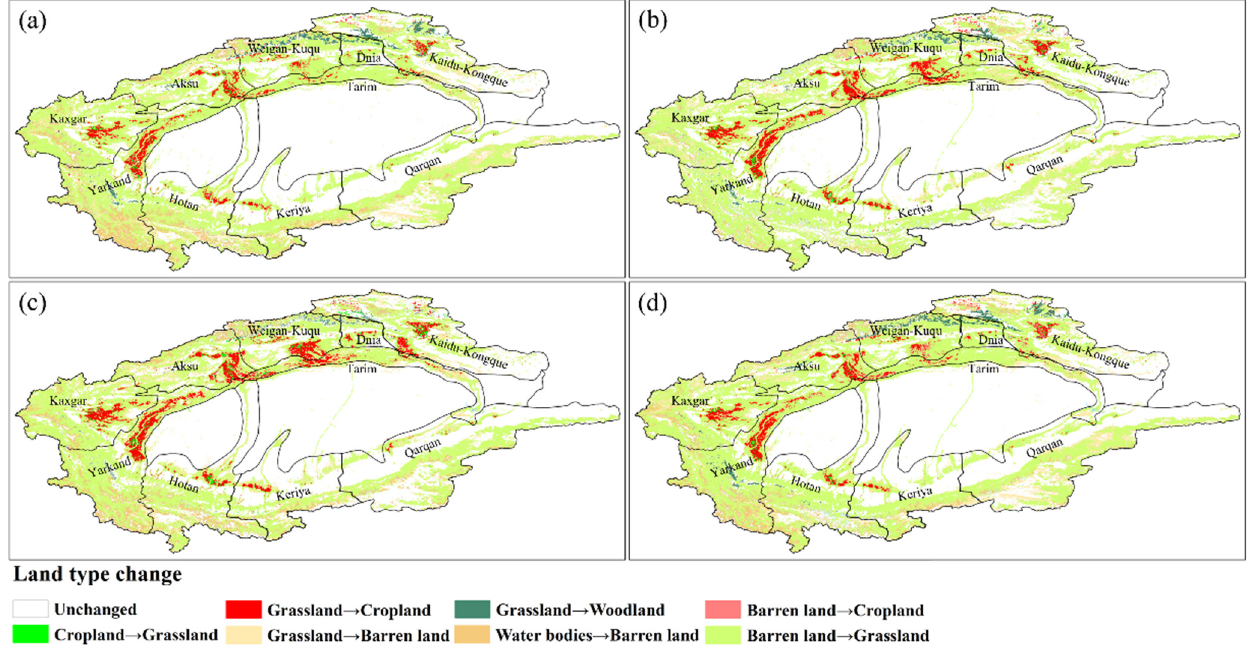
Figure 5. Land-use transfer map of the Tarim River Basin from 1990 to 2019: ( a ) 1990–2000; ( b ) 2000– 201; ( c ) 2010–2019; and ( d ) 1990–2019.